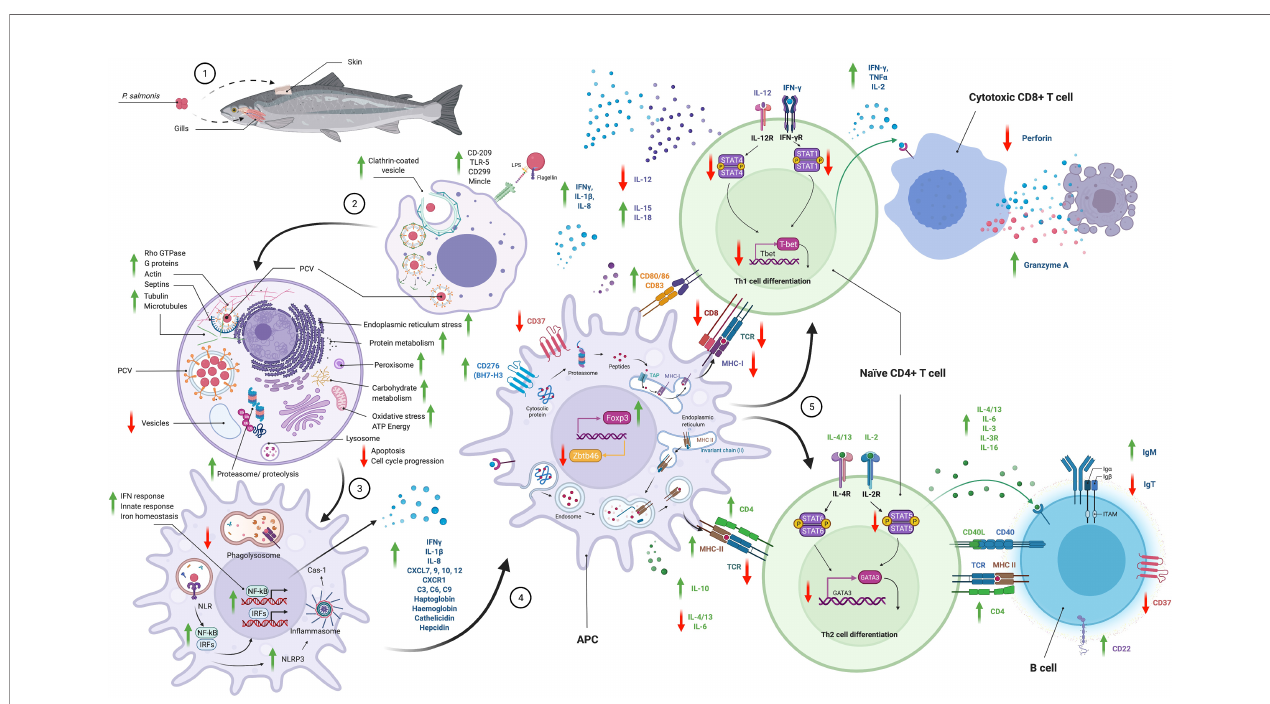
FIGURE 2 | Schematic summary of the pathways used by P. salmonis to enter to the cell and the immune responses modulated. This information was consolidated with results descrbed in different in vitro and in vivo transcriptomic and proteomic studies. Phagocytosis, key in the life cycle of P. salmonis , is also its primary mode of pathogenesis. The interaction of P. salmonis with host cells has been described by different transcriptomic and proteomic studies in vitro and in vivo (10 – 13, 29, 30, 78, 89, 93 – 107). P. salmonis infection consists of an early or vacuolization stage and a late or spreading stage. (1) Several studies have reported that the main route of entry of the bacterium into the fi sh is through the gills and skin and, to a much lesser extent, the oral route. (2) P. salmonis is internalized by clathrin- dependent endocytosis into phagocytic cells. Pilus proteins, beta-hemolysin, and the T6SS are a characteristic fi nding of the vacuolization stage. The transport of carbohydrates, amino acids, peptides, iron, and other nutrients is increased inside the PCVs. (3) Once inside, a major reorganization of the cytoskeleton occurs by altering actin fi laments, tubulins, myosins, and septins, and P. salmonis simultaneously promotes an inactive GTPase state. P. salmonis induces a signi fi cant inhibition of the antioxidant response that would promote the generation of an oxidative niche. Overall, P. salmonis alters cytoskeletal remodeling, intracellular transport, organelle organization, vesicle and endosome traf fi cking and early endosomal components. The antigen recognition (LPS, fl agellin, etc.) is conducted by macrophage and dendritic cell (DC) PRRs, such as TLR5, DC-SIGN or CD209, C-type lectin (CD299, Mincle), and NLR. DCs play an important role in the response to P. salmonis by modulating NF-kB activation, pathogen recognition, phagocytosis and the production of cytokines and chemokines led by the IFN-mediated response that promotes Th1 polarization of T cells. At the same time, to enhance its survival in infected cells, P. salmonis upregulates IL-10 but downregulates IL-12, which promotes Th1 polarization. P. salmonis induces fl agellin-dependent activation of TLR5, resulting in TNF a , IL-1 b and IL-8 production. P. salmonis promotes the expression of antimicrobial peptides, such as hepcidin and cathelicidin, and acute-phase components such as haptoglobin, hemoglobin, collectrins, mannose-bound protein C, complement components (C3, C6, C9) and CD163. All these fi ndings con fi rm that P. salmonis creates a speci fi c environment that promotes their survival and replication in macrophages. During the propagation stage, the size and number of P. salmonis cells and vesicles increase, and nutrient availability is restricted, initiating a stringent response. Biosynthetic processes are increased in both P. salmonis and host cells, as are iron acquisition, iron transporter proteins and acute- phase responses. Expression of Dot/Icm T4SS genes, toxins, effector proteins, mobilome, transposons, and phage-related proteins is increased, probably in preparation for exiting the cell. Many virulence factors upregulated in both infection stages correspond to plasmid-encoded proteins, which supports the hypothesis of the importance of P. salmonis plasmids in the infective process. P. salmonis modulates the immune response to intracellular pathogens by promoting cell cycle proliferation and suppressing apoptosis and by altering vesicle traf fi cking and paracellular permeability. P. salmonis alters peroxisome activity as part of its infection strategy, thereby inducing an altered cellular redox balance, in fl ammation, and immune response. Moreover, P. salmonis reduces the rate of protein degradation by the ubiquitin proteasome system related to the response to cellular and endoplasmic reticulum stress-associated unfolded proteins as a mechanism to increase its survival within host cells. (4) Processing and presentation of antigens. T cells recognize only antigen fragments that are bound to MHC-I or MHC-II on APCs. Antigens presented by MHC-I are processed through the proteasome and transferred to the endoplasmic reticulum by a transporter associated with antigen processing (TAP) where they associate with MHC-I and are fi nally transported to the cell membrane. MHC-II-presenting antigens are incorporated into cells by endocytosis, digested in lysosomes and loaded onto MHC-II molecules prior to migration to the cell surface. However, P. salmonis inhibits the MHC-I pathway ( mhc1, cd8, tcra, tcrb gene underexpression) but activates the MHC-II pathway ( mhc2, cd4 ), so its strategy is to evade the CD8+ T cell-mediated immune response. P. salmonis increases the expression of important co-stimulatory molecules on the macrophage surfaces ( cd80/86, cd83 ) and reduces the expression of zbtb46 , a transcriptional factor that inhibits APCs maturation (5) T cell activation and differentiation. CD4+ T helper cells can differentiate into Th1, Th2, Th17 and Treg populations, which play different roles in the immune response. IL-12 promotes the differentiation of CD4 cells into Th1 cells to eliminate intracellular pathogens, while IL-2, IL-4, IL-13A, and IL-10 promote the differentiation of Th2 cells in response to bacteria and extracellular parasites. However, P. salmonis promotes IFN- g production but reduces IL-12 production, reduces the expression of Th1 polarization-speci fi c transcription factors ( tbet , eomes ) and, while promoting granzyme A expression ( gzma ), reduces perforin ( mpeg1 ) production. In addition, P. salmonis increases the expression of Treg polarization-speci fi c transcription factor ( foxp3 ) suggesting the activation of an immune tolerance